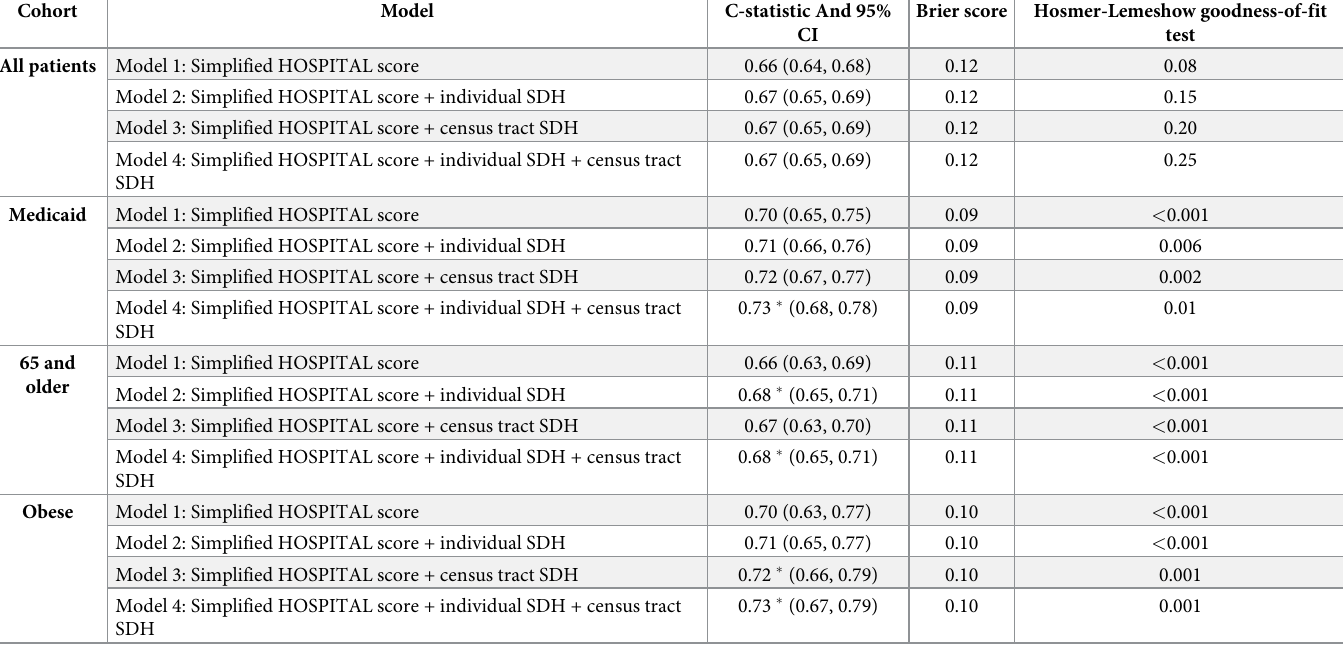
Table 3. Performance of the predictive model for 30-day readmission or death. Cohort Model All patients Model 1: Simplified HOSPITAL